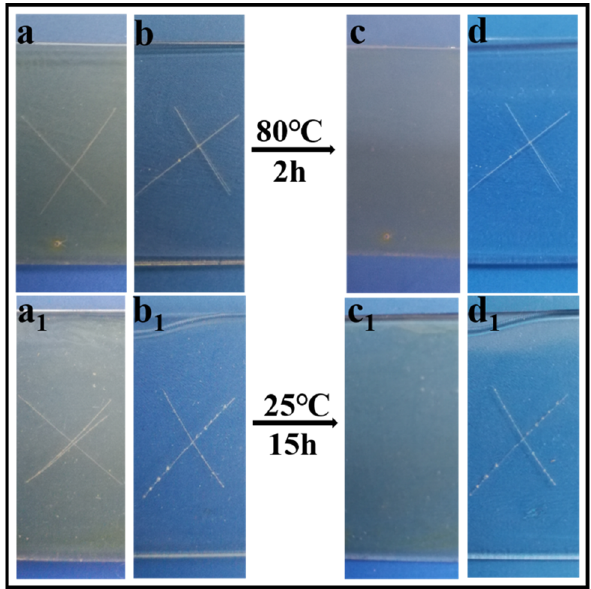
Figure 3. Self-healing performance: Coating scratch images of P(CTFE- alt -IBVE)/MFWPU ( a , a 1 ), P(CTFE -alt- IBVE)/WPU ( b , b 1 ), P(CTFE- alt -IBVE)/MFWPU ( c ) and P(CTFE -alt- IBVE)/WPU ( d ) at 80 P(CTFE- alt -IBVE)/WPU ( b , b 1 ), P(CTFE- alt -IBVE)/MFWPU ( c ) and P(CTFE- alt -IBVE)/WPU ( d ) at °C for 2 h and P(CTFE- alt -IBVE)/MFWPU ( c 1 ) and P(CTFE -alt- IBVE)/WPU ( d 1 ) at 25 °C for 15 h. 80 ◦ C for 2 h and P(CTFE- alt -IBVE)/MFWPU ( c 1 ) and P(CTFE- alt -IBVE)/WPU ( d 1 ) at 25 ◦ C for 15